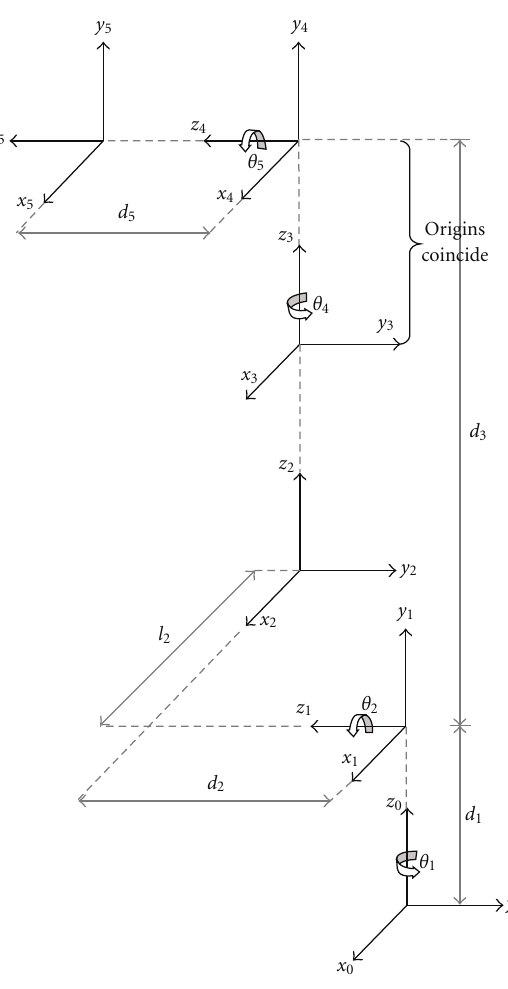
Figure 2: Assignment of coordinate